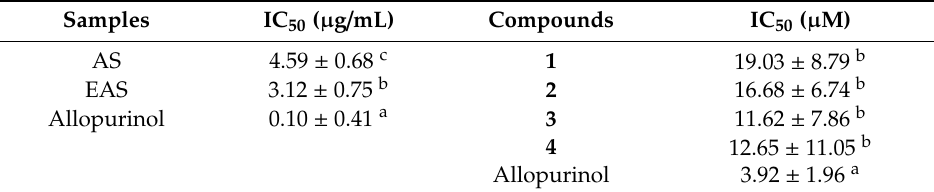
Table 2. IC 50 values of AS, EAS, and the isolated compounds for the nitroblue tetrazolium (NBT) superoxide scavenging activity.